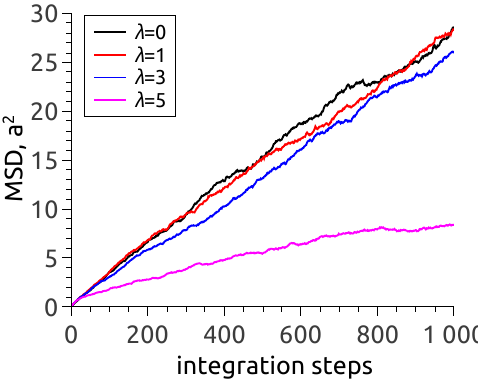
Figure 3. Mean-square displacement of nanoparticles at zero field in the MPS membrane filled to 11vol.% under variation of the magneto-dipole